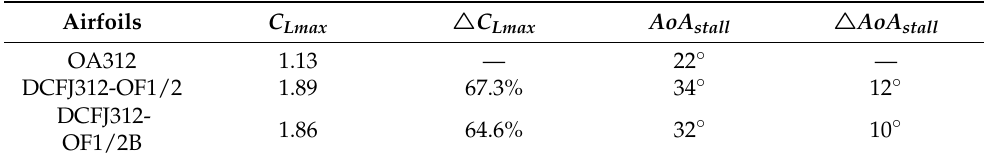
Table 12. Comparisons of lift coefficients of DCFJ312 airfoils with various RUL s at typical AoAs.